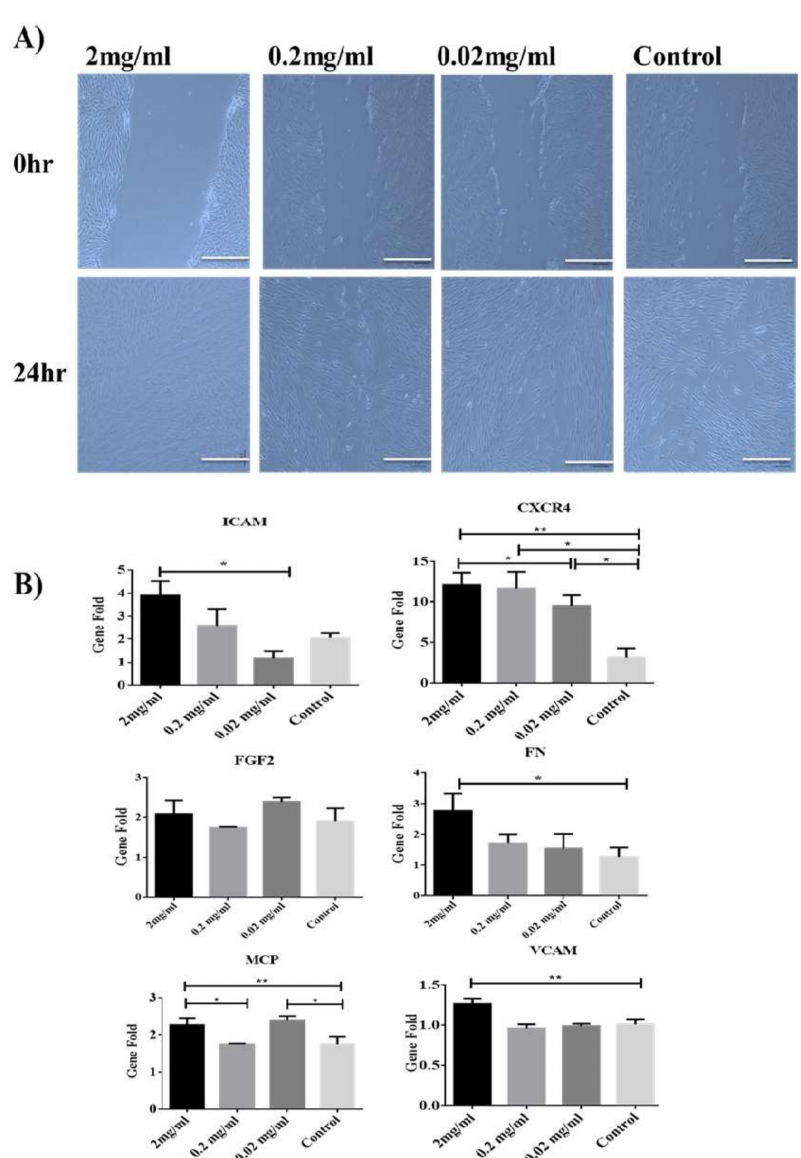
Figure 2. E ff ect of Biodentine on wound healing. ( A ) Microscopic photographs (100 × ) of PDLSCs treated with di ff erent concentrations of Biodentine ™ (2, 0.2, 0.02 mg / mL) and controls. ( B ) Measurement of the expression levels of migration genes CCXR4, MCP, FN, FGF2, VCAM and ICAM-1, among all treated groups after 24 h of wound closure by using qPCR. (** p < 0.005, * p <